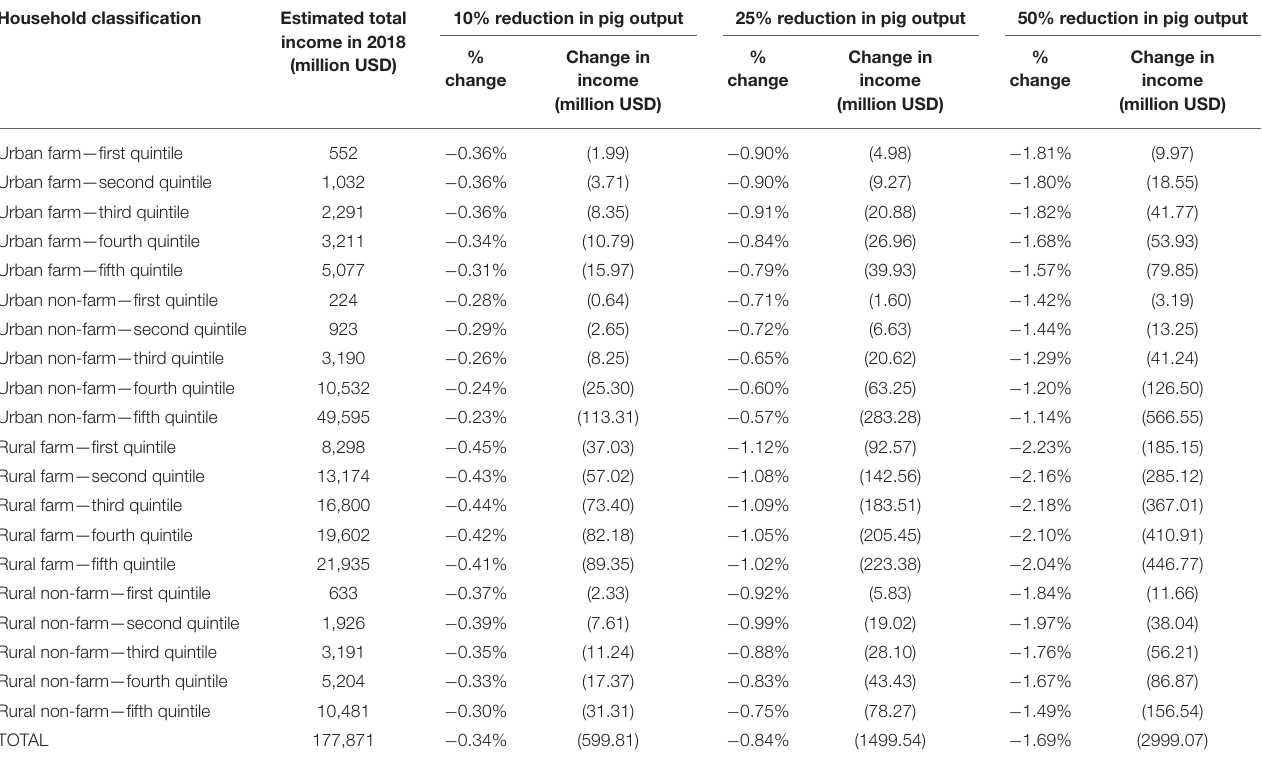
TABLE 6 | Impacts on household income groups induced by a reduction in the value of pig output caused by ASF under different